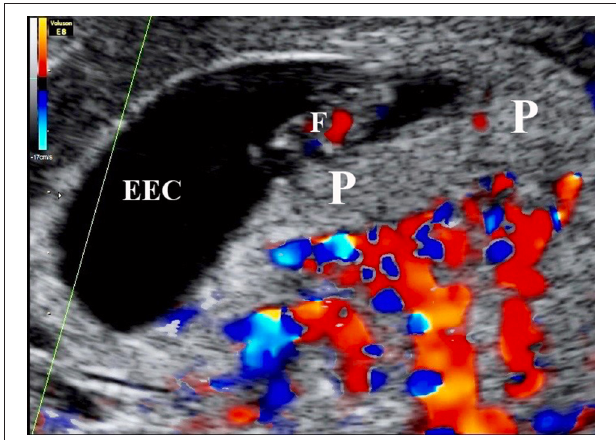
FIGURE 3 | Color Doppler mapping of the utero-placental circulation at 7 weeks 2 days of gestation showing the absence of circulation within the placenta (P). ECC, exocoleomic cavity; F,